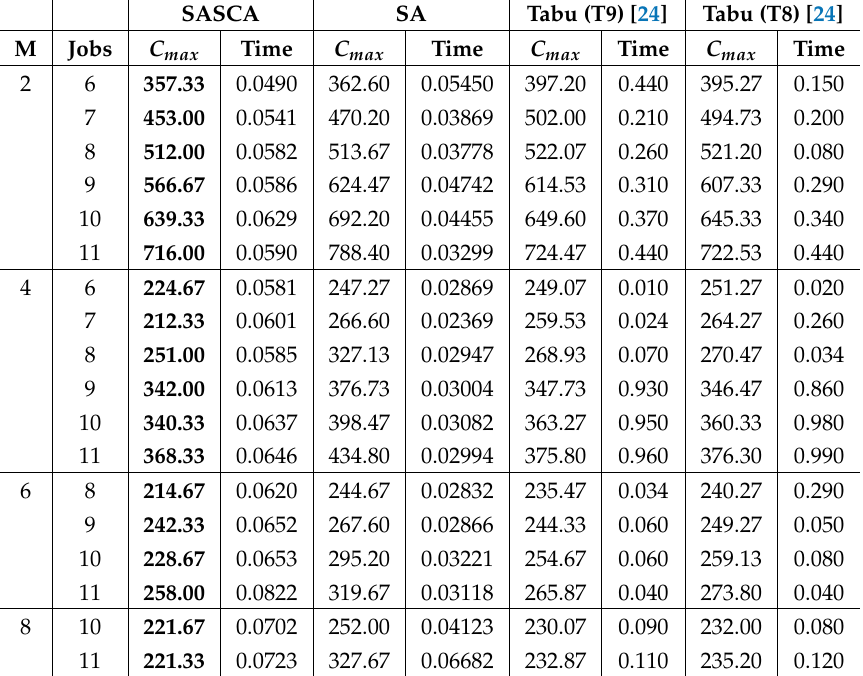
Table 4. Average of C max values of the small problems for each algorithm (best results are in boldface). SASCA SA Tabu (T9) [24] Tabu (T8) [24]